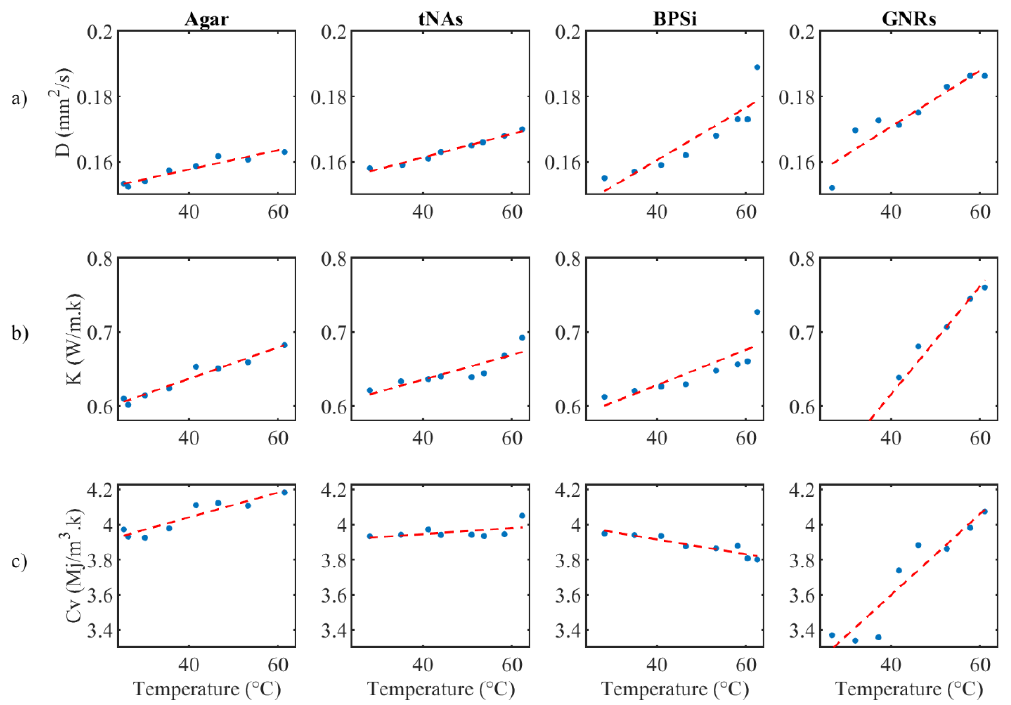
Figure 6. ( a ) Fitting curve for ( a ) thermal diffusivity, ( b ) thermal conductivity and ( c ) volumetric heat capacity, for agar with and without NPs.